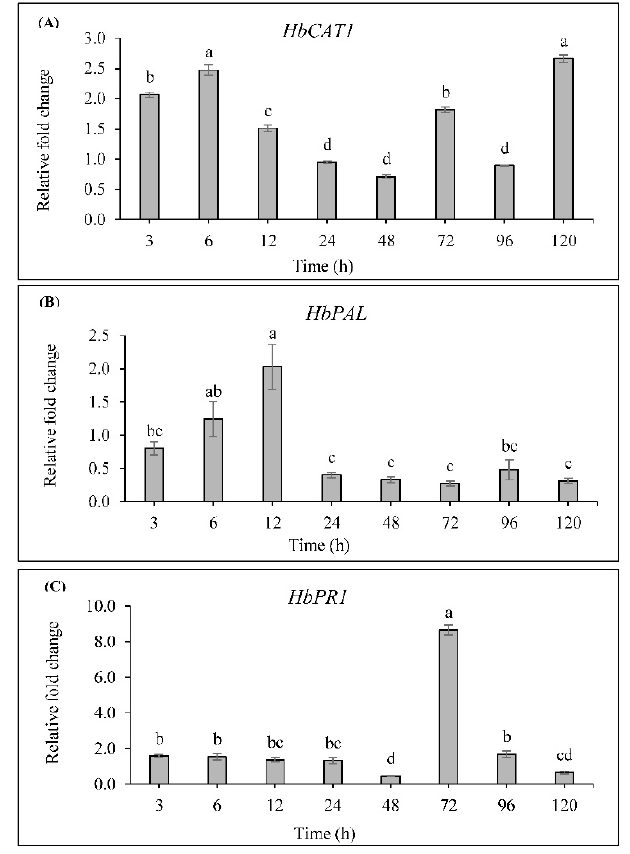
Figure 8. Effect of SA on transcript abundant of ( A ) HbCAT1 ; ( B ) HbPAL ; ( C ) HbPR1 genes in rubber tree. The leaves of rubber tree seedlings were sprayed with either distilled water or 5 mM SA. Total RNA was extracted from the leaves taken at various time points (3, 6, 12, 24, 48, 72, 96 and 120 h), converted to cDNA, and subjected to semi-qRT-PCR. Relative transcript levels were calculated relative to expression of Hbmitosis mRNA. The expression levels of HbCAT1 , HbPAL and HbPR1 genes were expressed as a relative transcript fold change to their controls. All data show the average of three replications. Error bars indicate standard errors. Different letters represent significant differences, according to Tukey’s HSD test at p ≤ 0.05.